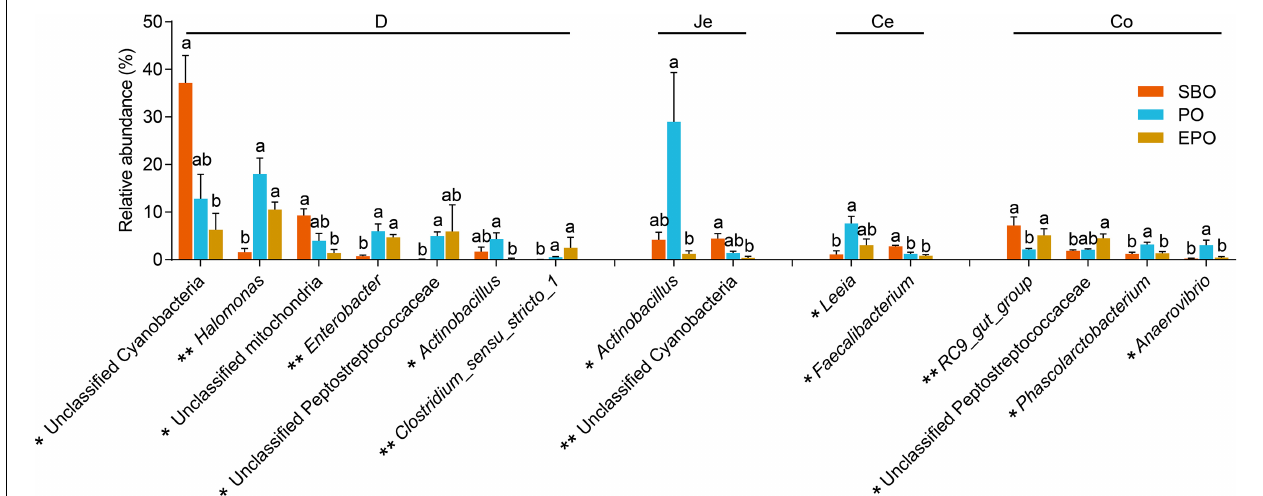
FIGURE 4 | The significantly changed genera found in each segment of intestine of piglets (the mean abundance more than 2% at least one group, analyzed using Kruskal Wallis sum-rank test). * P < 0.05; ** P < 0.01. D-, duodenum-; Je-, jejunum-; Ce-, cecum-; Co-, colon; SBO, soybean oil; PO, palm oil; EPO, encapsulated palm